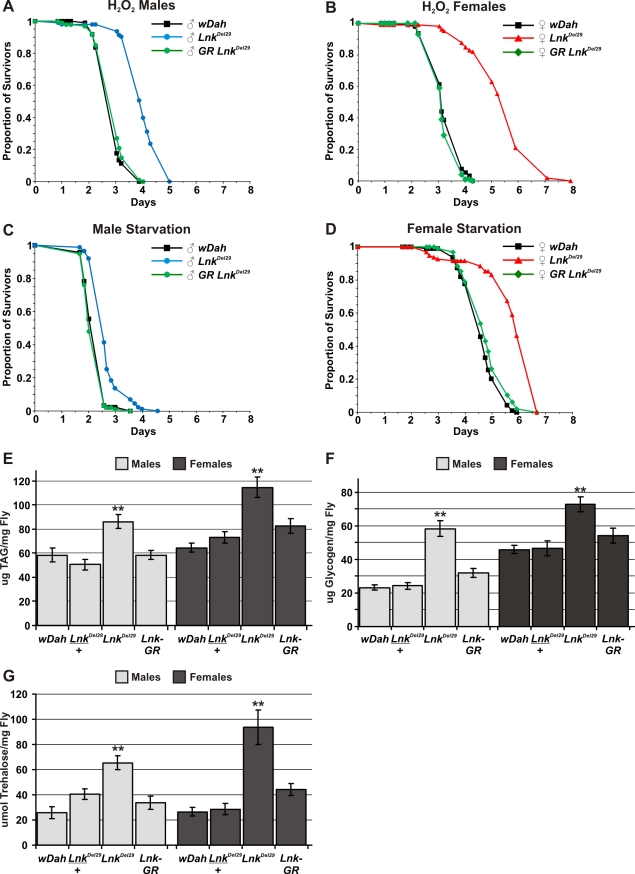

Lnk mediates responses to oxidative stress and starvation and is required for metabolic regulation.(A) Survival of male flies fed 5% hydrogen peroxide. Lnk mutant males live approximately 50% longer than controls and mutants carrying a Lnk genomic rescue (GR) construct (p<0.001). Median survival times are 2.6 days for wDah (black line; n = 97), 3.9 days for LnkDel29 (blue line; n = 93) and 2.6 days for LnkGR; LnkDel29/LnkDel29 (green line; n = 100). (B) Survival of female flies fed 5% hydrogen peroxide. Lnk mutant females live approximately 50% longer than controls and mutants carrying a Lnk genomic rescue (GR) construct (p<0.001). Median survival times are 3.1 days for wDah (black line; n = 93), 5.6 days for LnkDel29 (red line; n = 105) and 3.1 days for LnkGR; LnkDel29/LnkDel29 (green line; n = 100). (C) Survival of male flies under starvation conditions. Lnk mutant males live 30% longer than controls and mutants carrying a Lnk genomic rescue (GR) construct (p<0.001). Median survival times are as follows: 2.0 days for wDah (black line; n = 92), 2.6 days for LnkDel29 (blue line; n = 86) and 1.9 days for LnkGR; LnkDel29/LnkDel29(green line; n = 97). (D) Survival of female flies under starvation conditions. Lnk mutant females live 35% longer than controls and mutants carrying a Lnk genomic rescue (GR) construct (p<0.001). Median survival times are as follows: 4.3 days for wDah (black line; n = 94), 5.8 days for LnkDel29 (red line; n = 95) and 4.7 days for LnkGR; LnkDel29/LnkDel29 (green line; n = 95). (E) Whole-fly content of triglycerides (TAG) per mg of fly (fresh weight). Data are presented as means (n = 10) ± SEM. ** denotes statistically significant difference (p<0.05). (F) Whole-fly glycogen content per mg of fly (fresh weight). Data are presented as means (n = 10) ± SEM. ** denotes statistically significant difference (p<0.05). (G) Whole-fly trehalose content per mg of fly (fresh weight). Data are presented as means (n = 10) ± SEM. ** denotes statistically significant difference (p<0.05).